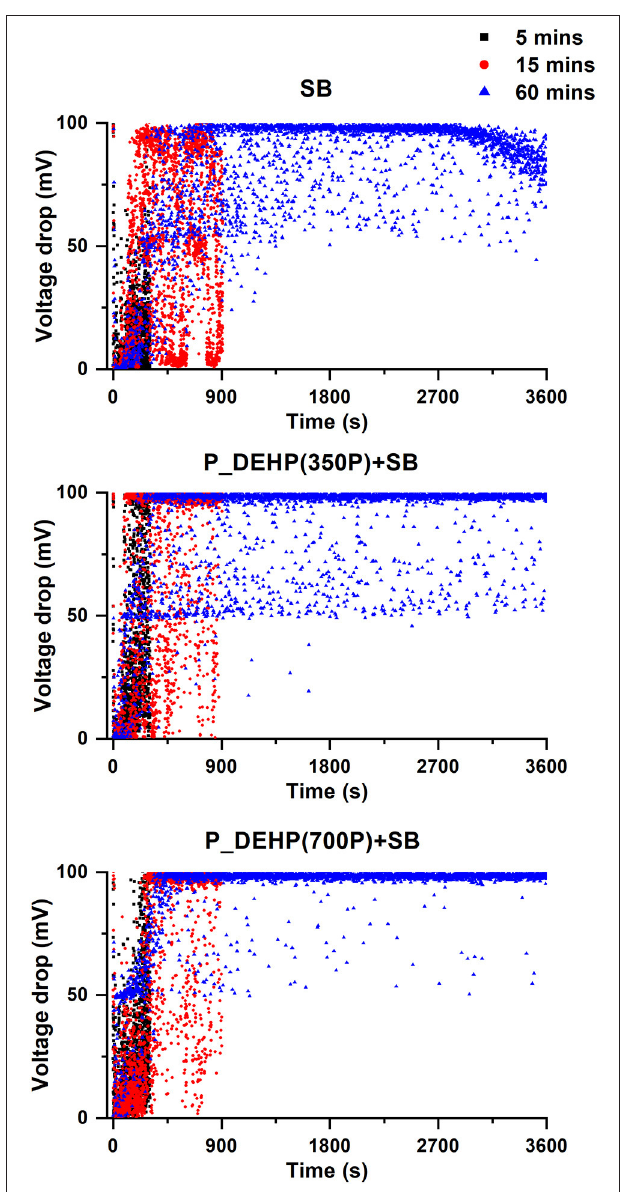
FIGURE 6 | ECR data acquired for SB, P_DEHP(350P) + SB and P_DEHP(700P) + SB for 5min (black), 15min (red), and 60min (blue) tests.